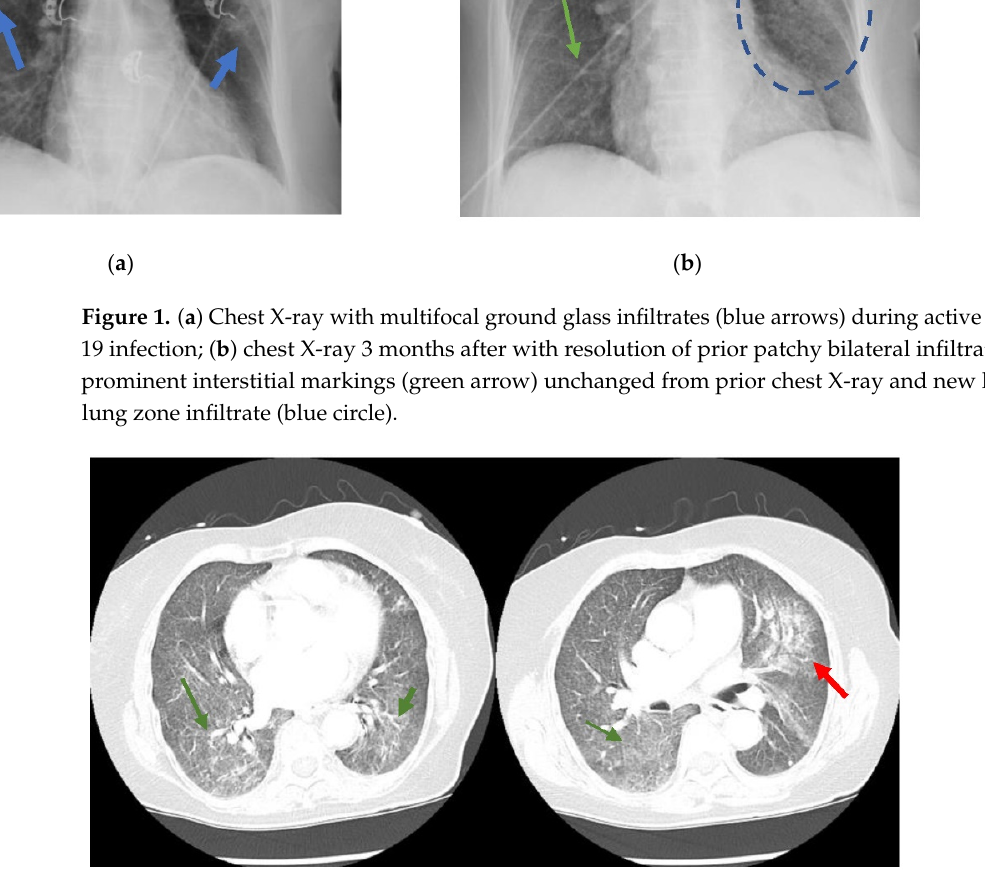
Figure 2. CT chest scan with diffuse ground glass opacities throughout both lungs more extensive than present on prior imaging (green arrows) with a superimposed patchy airspace consolidation in the perihilar region of the left upper lung lobe (red arrow).